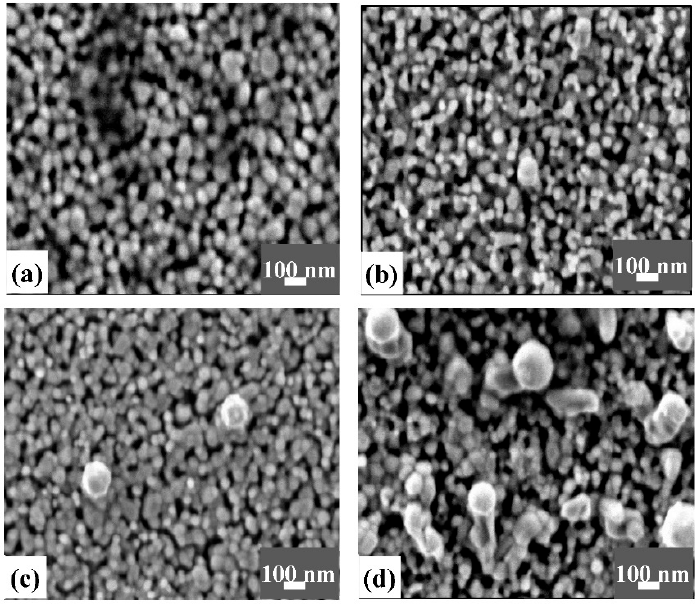
Figure 5. SEM images of the surface morphology, at a scale of a few hundred nm, of pure ZnO thin film ( a ) and ZnO/Ag(NPs) nanocomposite thin films elaborated with different Ag NPs: contents: 5% ( b ), 10% ( c ), and 30% ( d ).